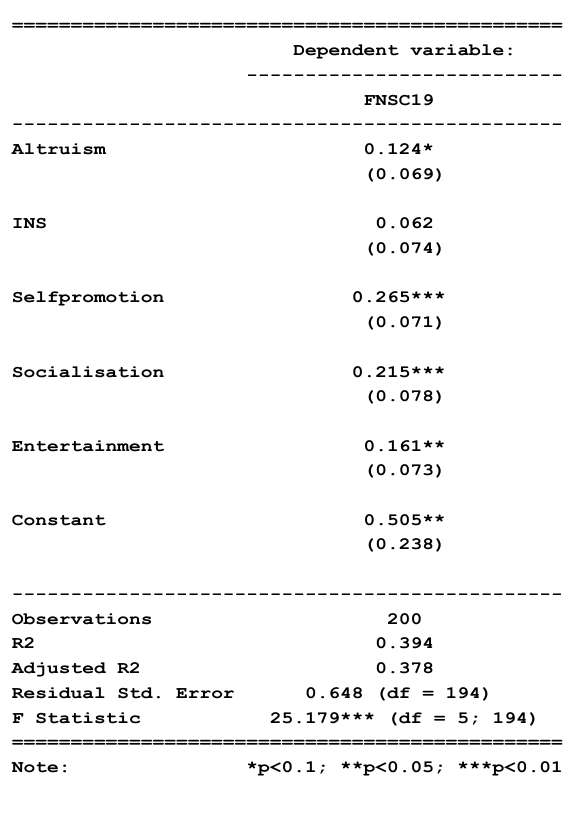
Table 4: The Results of Multiple Linear Regression Analysis (Source: Authors’